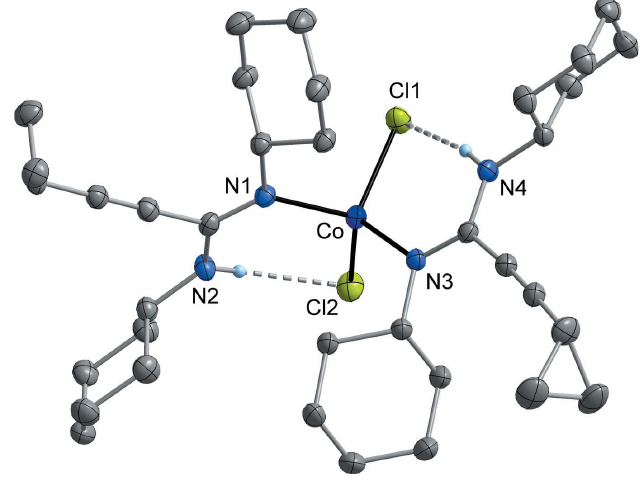
Figure 5 Molecular structure of 6 in the crystal. Displacement ellipsoids are drawn at the 50% level, C-bound H atoms omitted for